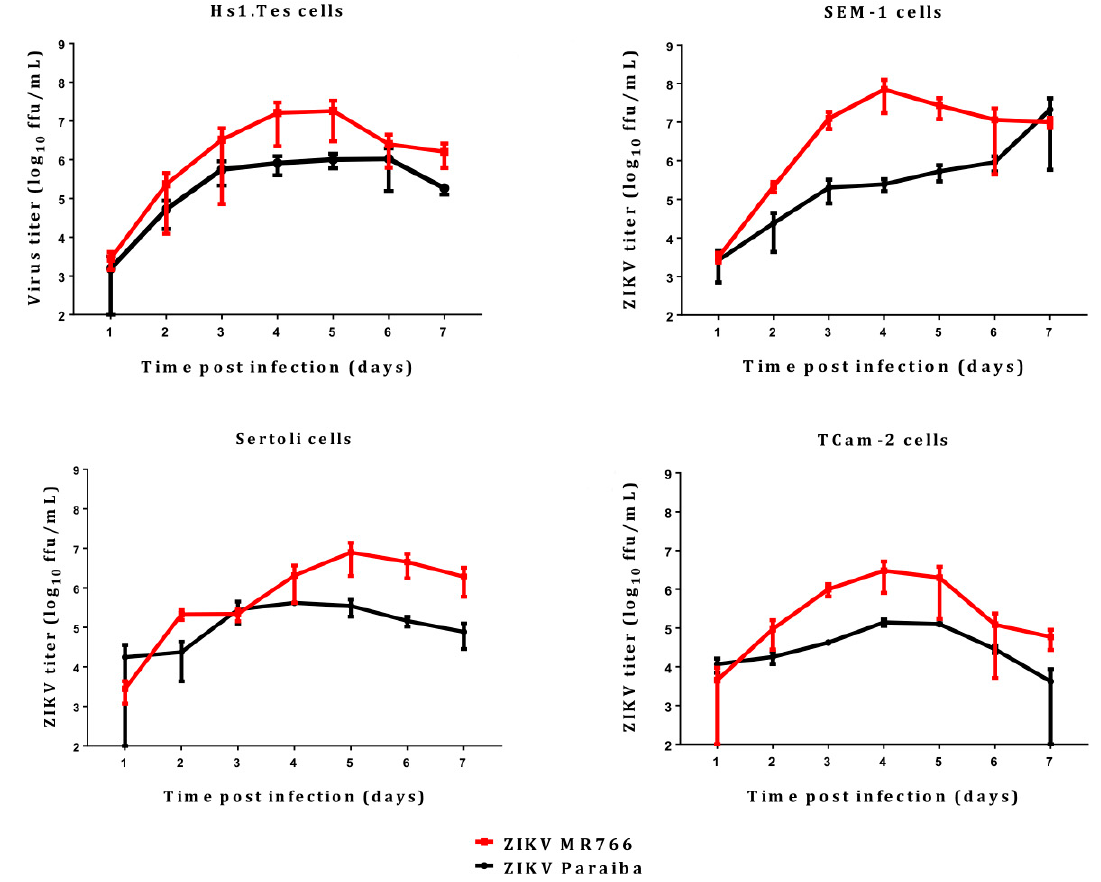
Figure 1. Replication kinetics of ZIKV MR766 and Paraiba over the course of 7 days. Error bars represent standard deviation (SD) from the mean for 3 independent replicates.